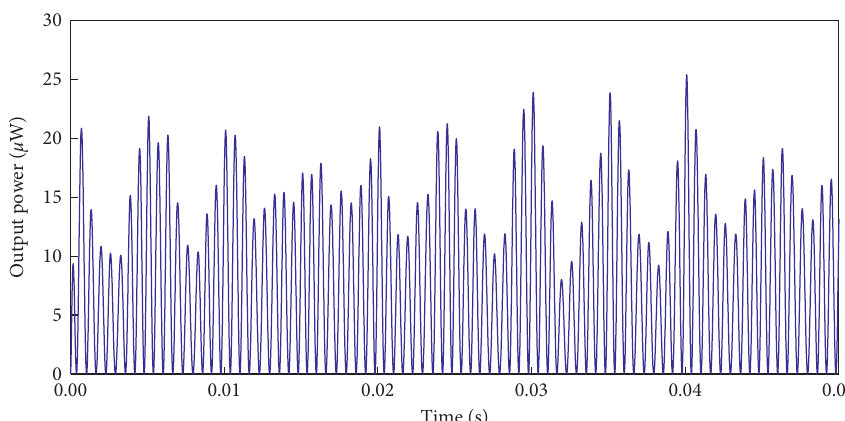
Figure 15: Output power of harvester under urban railway noise.